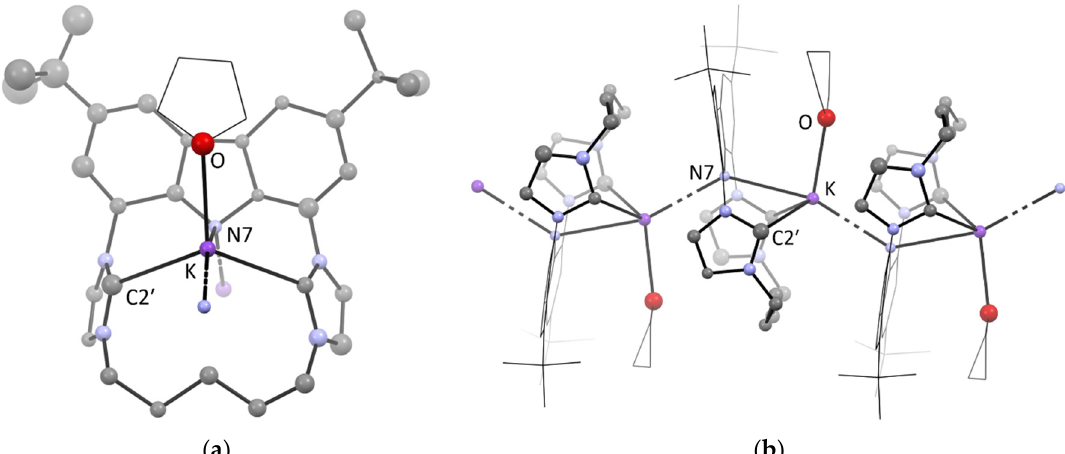
Figure 2. Two views of the isotropically refined structure of complex [K(bimca C5 )] ( 3 ). For clarity, the wireframe style is used for the coordinated THF and the bimca framework where suitable. Co-crystallized solvent and hydrogen atoms have been omitted for clarity: ( a ) view along the two-fold axis polymer chain with one monomer depicted; ( b ) side view of the coordination polymer. The K(bimca C5 )(THF) moieties are additionally coordinated by the carbazole nitrogen atom of the next complex that is rotated by 180° in a zig-zag fashion, thus forming a coordination polymer along a two-fold axis.